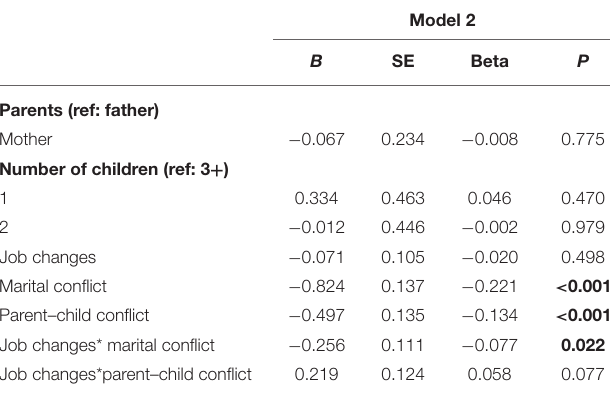
TABLE 3 | Analysis of the interaction effects between job changes and family conflicts on quality of